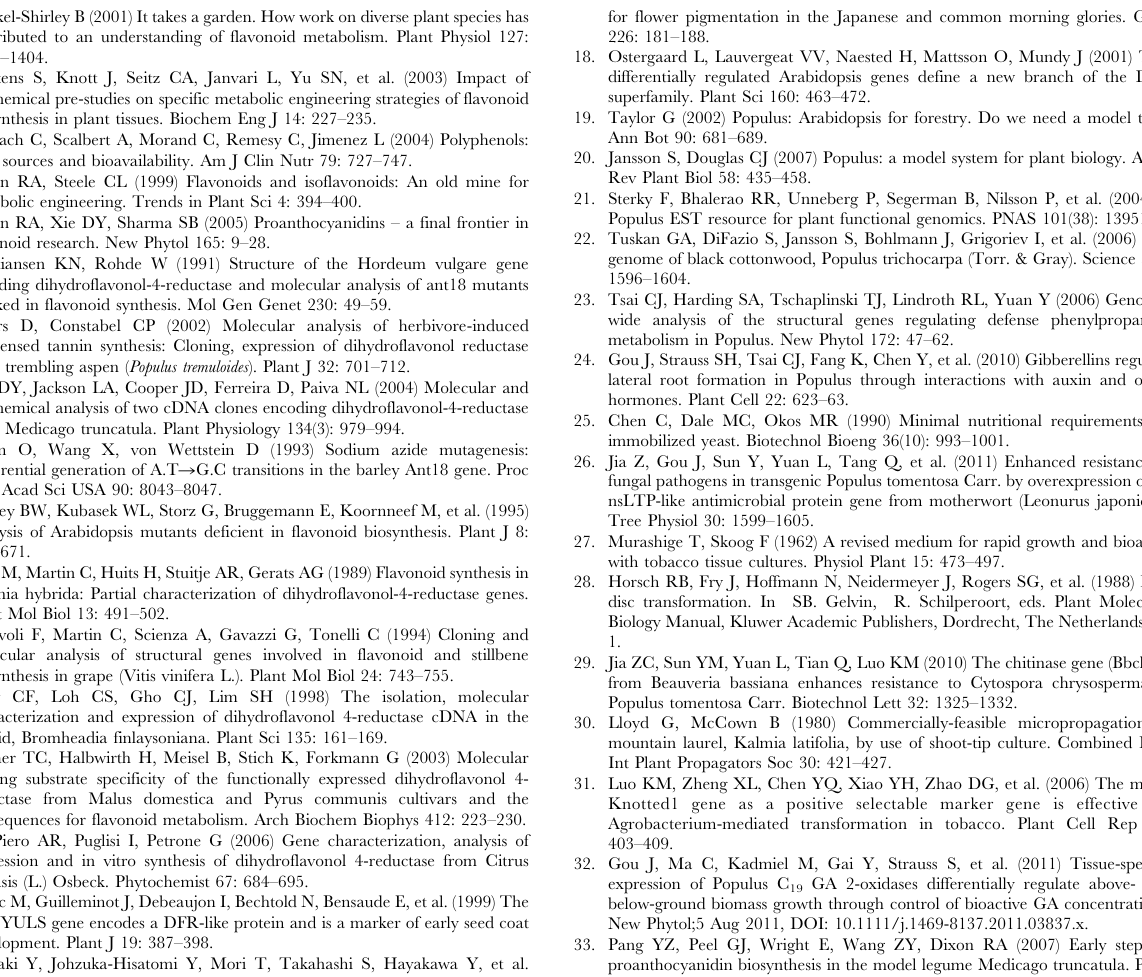
transgenic lines. Numbers on the left indicate DNA marker sizes in base pairs. (TIF) Figure S2 PCR analysis of transgenic P. tomentosa Carr. plants. PCR amplification using primers designed for a 741-bp fragment of the NPTII gene using total genomic DNA as the template. ( A ) Of 35S:PtrDFR1 transgenic lines (2, 3, 4, 5, 6, 7, 8, 10, 11, 12 and 15). ( B ) Of 35S:PtrDFR2 transgenic lines (1, 2, 4, 5, 7, 8, 9, 10, 11 and 14). M, D2000 DNA Ladder; WT, wild-type plants; pBI121, transgenic control; Plasmid, corresponding plasmid DNA (positive control). Numbers on the left indicate DNA marker sizes in base pairs.